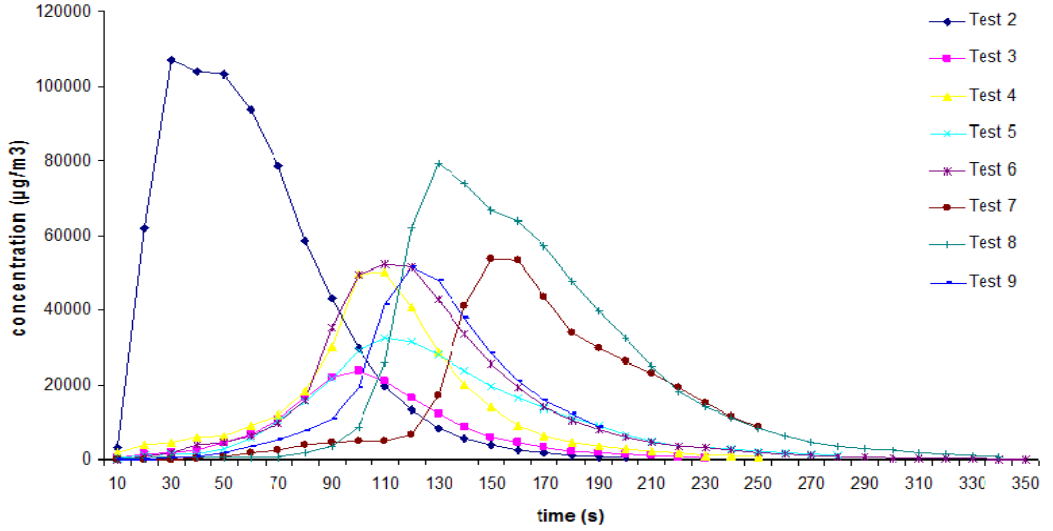
emitted during the burning 2.5